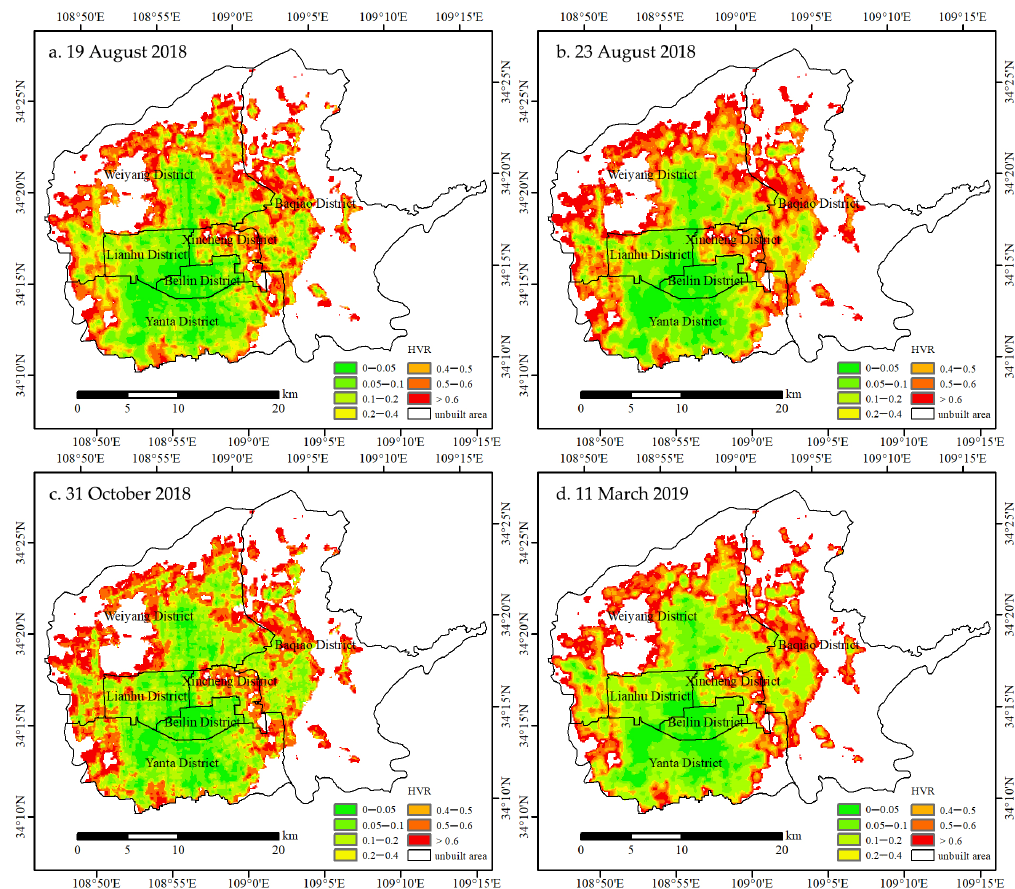
Figure 6. House vacancy rate at different times: ( a ) 19 August 2018; ( b ) 23 August 2018; ( c ) 31 October 2018; ( d ) 11 March 2019.